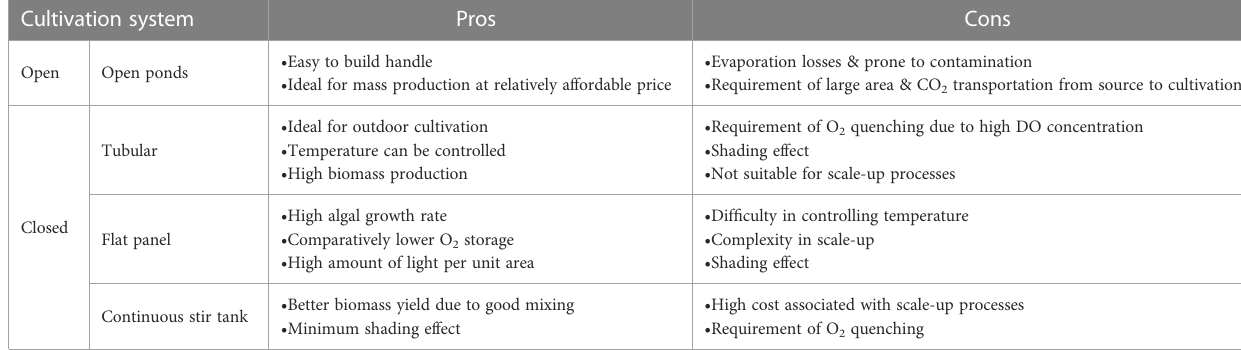
TABLE 2 Pros and cons associated with conventional algae cultivation systems (Ting et al., 2017; Chew et al., 2018). Cultivation system